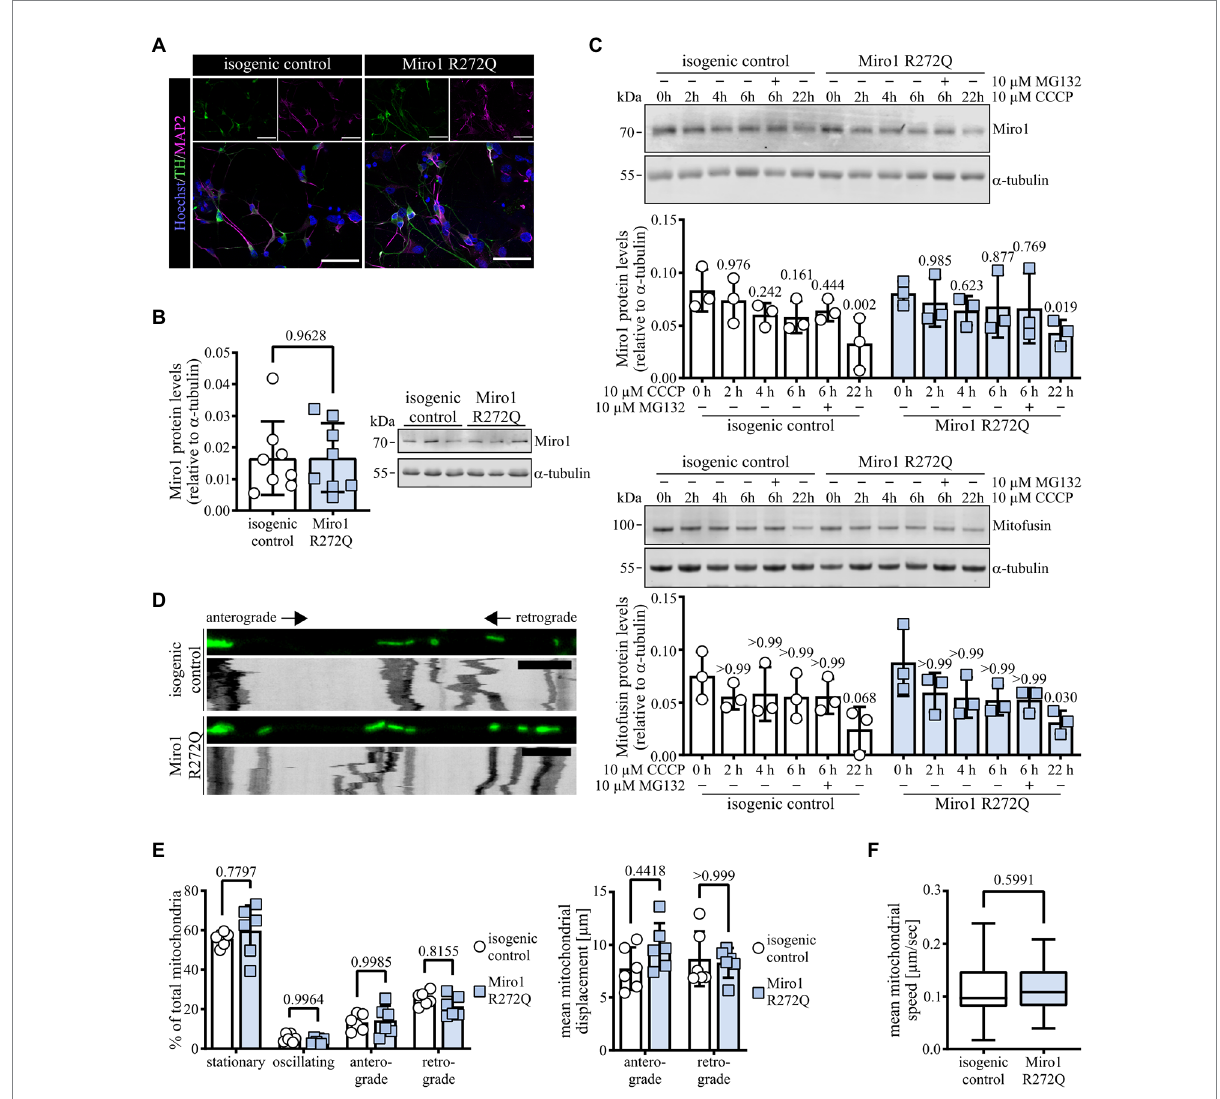
FIGURE 1 Miro1 R272Q does not change mitochondrial movement or Miro1 degradation upon CCCP-induced mitophagy. (A) Representative image of hDaNs stained with neuronal marker MAP2 and dopaminergic marker TH; n Diff = 3. Scale bar: 50 μ M. (B) Miro1 protein levels in hDaN lysates. Representative blot and quantification of intensity of Miro1 bands relative to a-tubulin. n Diff = 8, data displayed as mean ± SD; paired t test (two- tailed). (C) Miro1 and Mitofusin protein levels in hDaNs upon induction of mitophagy using 10 μ M CCCP for 0/2/4/6 (+ 10 μ M MG132)/22 h. Representative blot and quantification of intensity of Miro1 and Mitofusin bands relative to a-tubulin. n Diff = 3, data displayed as mean ± SD; Miro1: Two-way ANOVA with Tukey’s multiple comparisons; Mitofusin: Friedman test with Dunn’s multiple comparisons. (D) Representative first frame of movie and derived kymograph for movement analysis of hDaNs stained with 100 nM MitoTracker green. Scale bar: 10 μ M. (E) Kymograph analysis of mitochondrial movement to classify stationary/oscillating/anterograde/retrograde fractions and mean displacement of mitochondria. n Diff = 3 (2 datasets per differentiation), data displayed as mean ± SD; Fractions: Two-way ANOVA with Šídák’s multiple comparisons; Displacement: Friedman test with Dunn’s multiple comparisons. (F) Mean mitochondrial speed analyzed using TrackMate fiji plugin. n Diff = 3 (n Processes = 60), data displayed as mean ± SD; Mann–Whitney